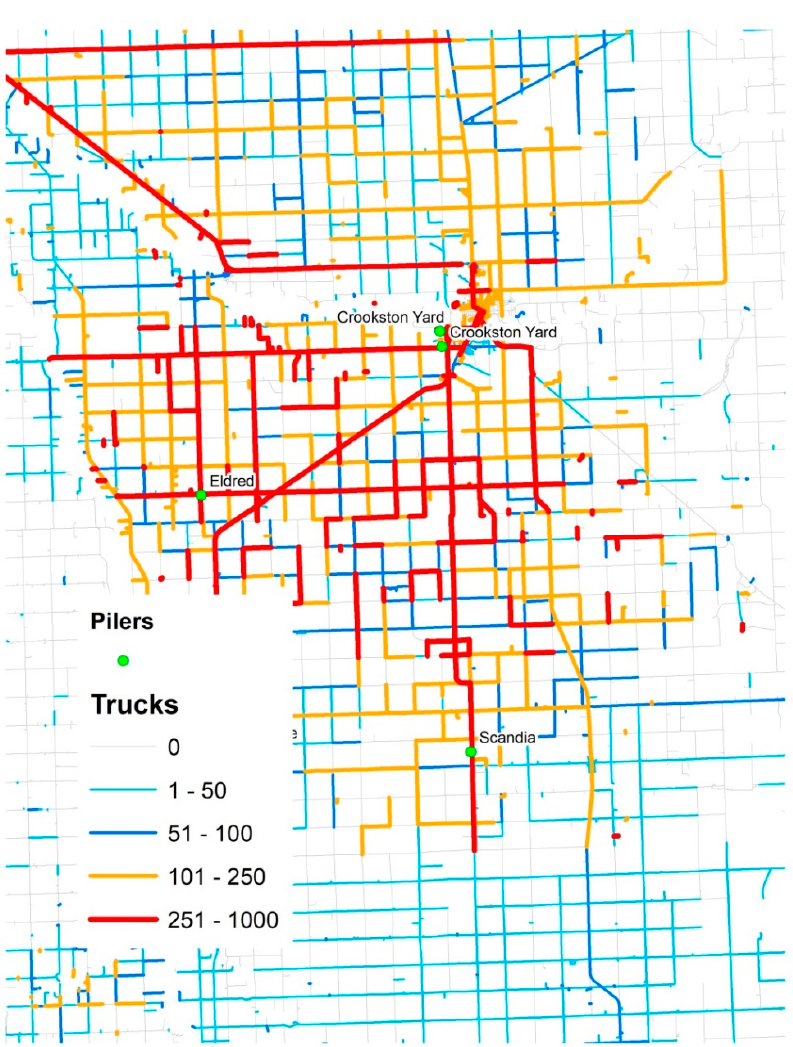
Figure 8. Truck volume on the road network near Crookston Yard for Week group 4.